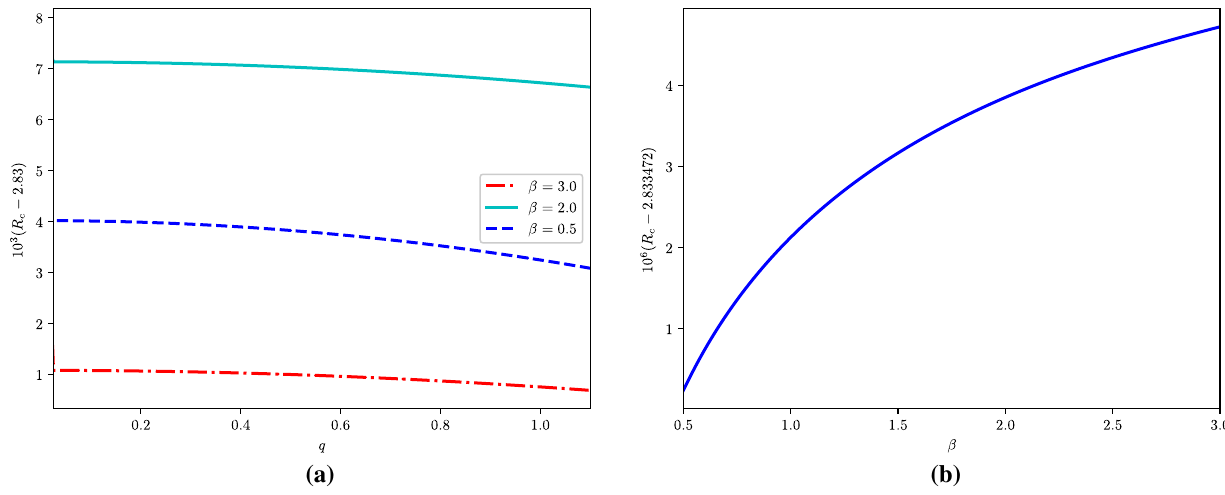
Fig. 5 a The profile functions A 0 and χ of a solution for the homogeneous charge distribution; β = 2 . 0, q = 0 . 4, R s = 1 / distributions of the same solution. The dotted red line shows r = R s and the dashed blue one r = R c